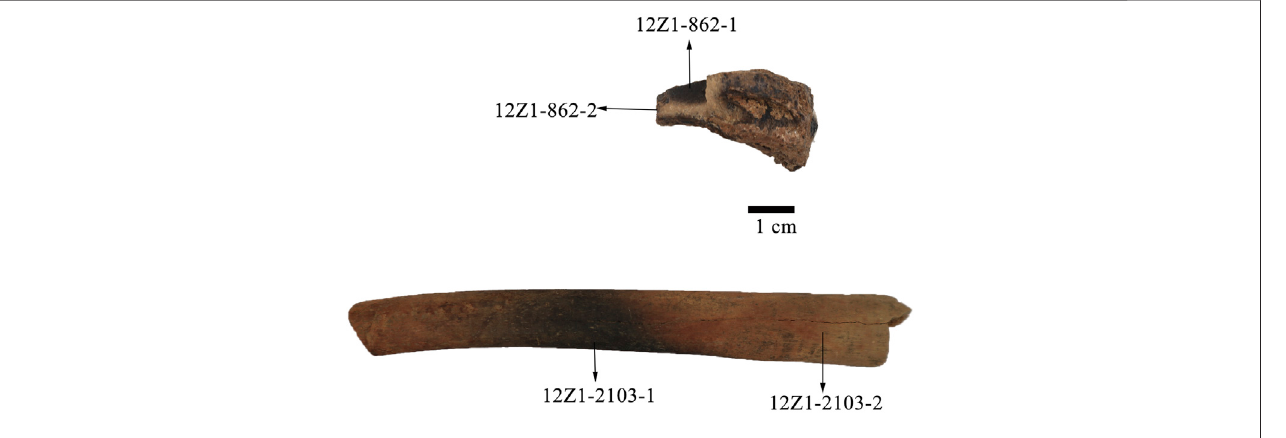
FIGURE 2 | Appearance of distinct colors in 12Z1-862 and 12Z1-2103.